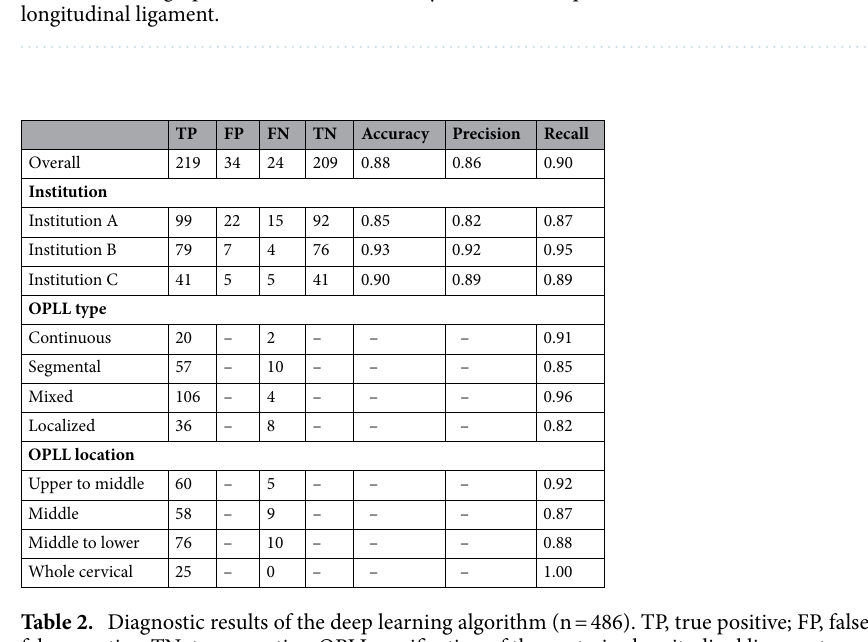
Table 1. Demographic data. #Mann–Whitney U test, *Chi-squared test. OPLL, ossification of the posterior longitudinal ligament.